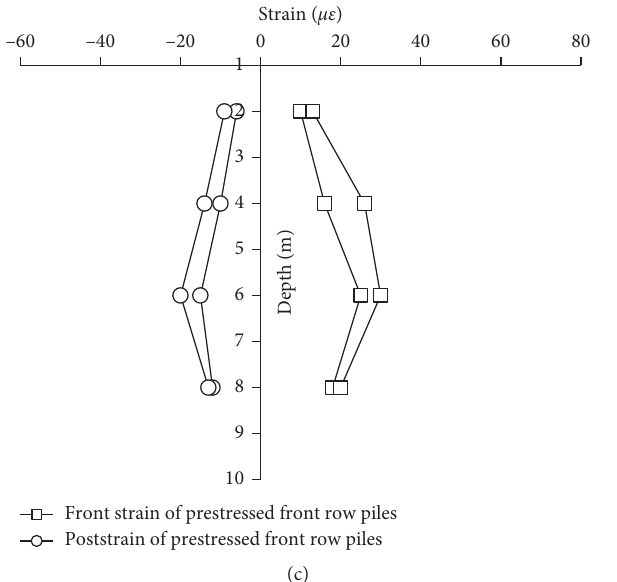
Figure 18: Variation of strain for front row piles. (a) Conventional pile. (b) Recycling assembled pile. (c) Prestressed strong-constrained pile.